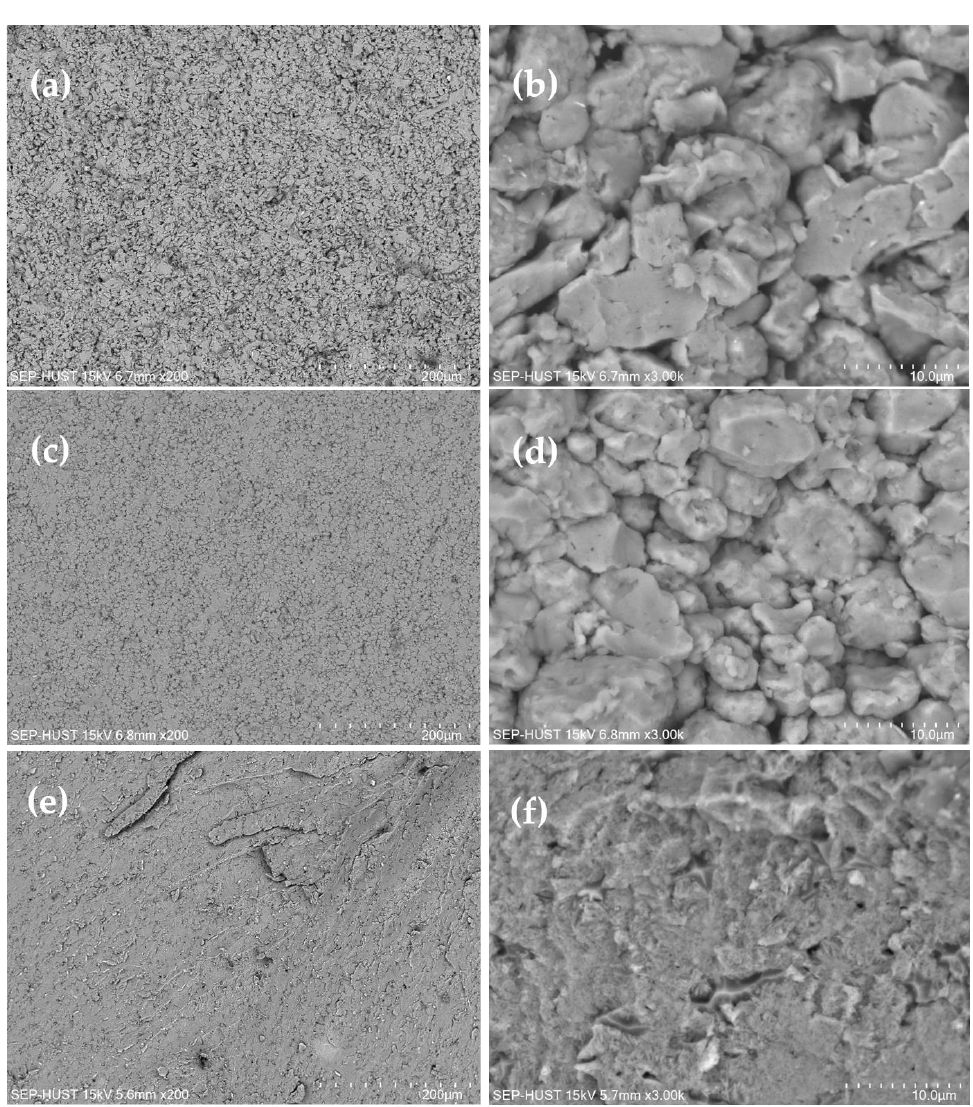
Figure 9. SEM images of the fracture surfaces of Al 82 Fe 14 Ni 4 samples sintered at ( a , b ) 450, ( c , d ) 500 and ( e , f ) 600 °C at different magnifications of 200× and 3000×.